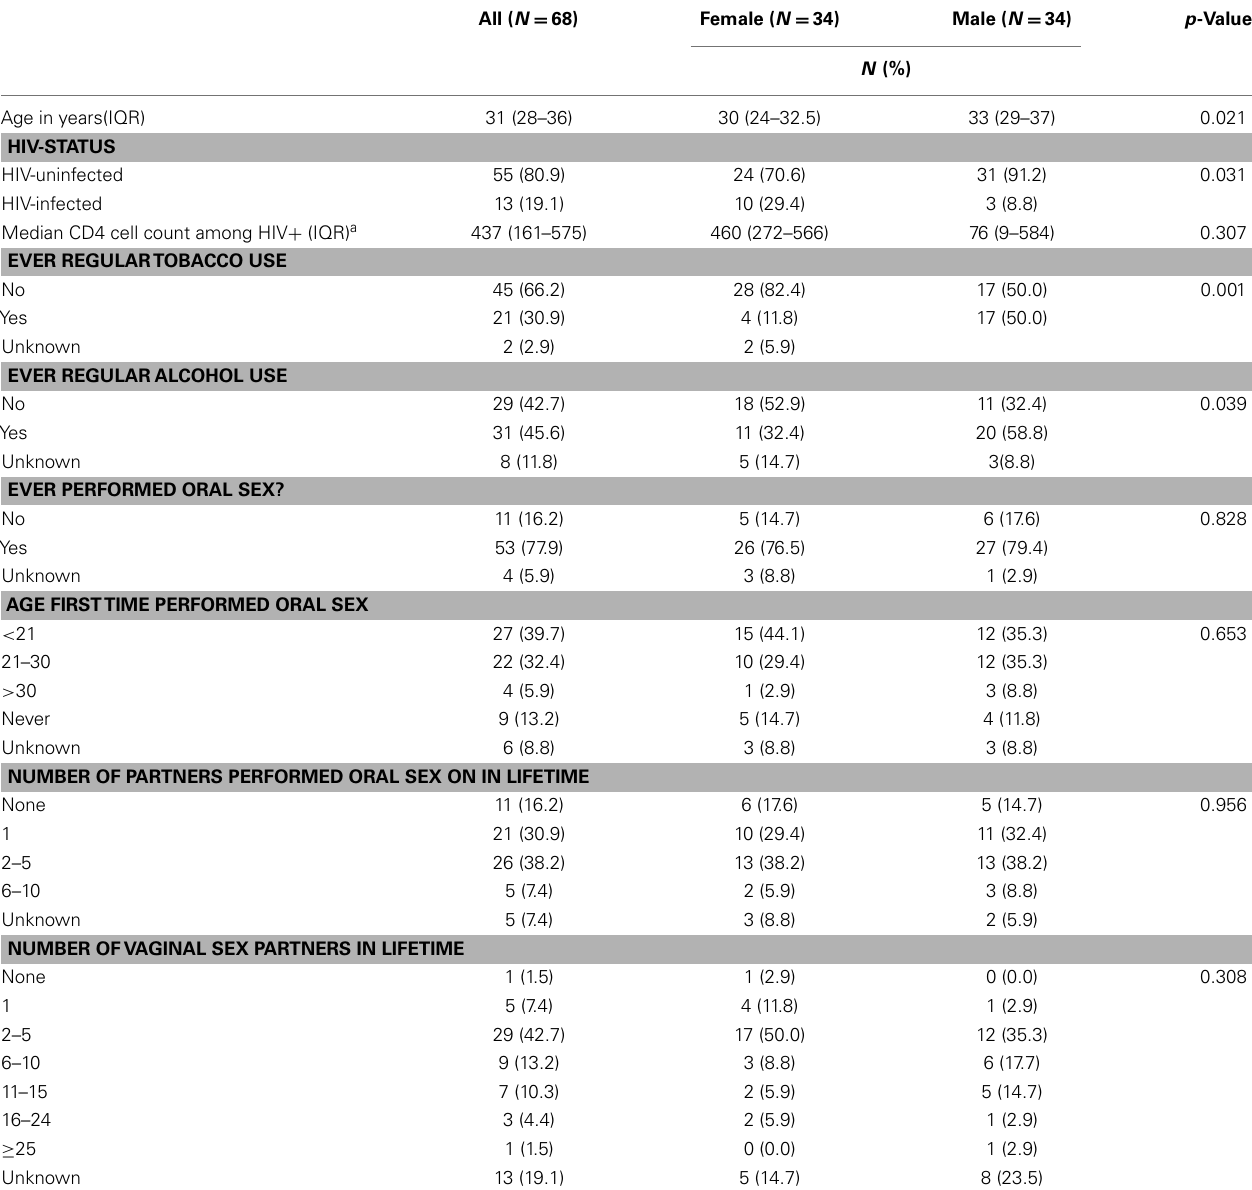
Table 1 | Characteristics of 34 couples attending Zazi Clinic for HIV counseling and testing, stratified by gender